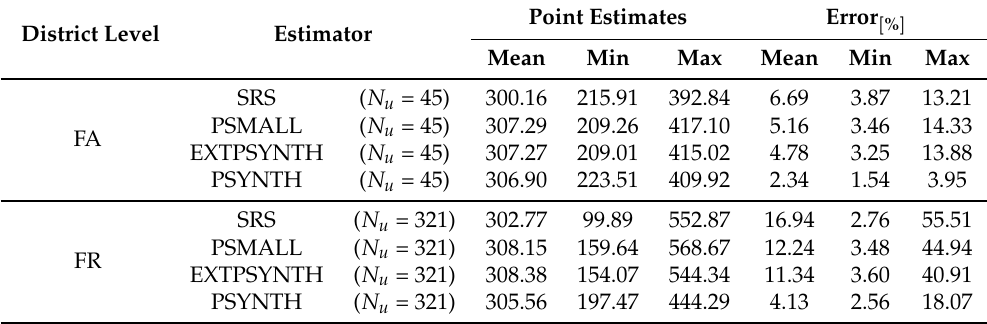
Table 6. Descriptive summary of point estimates and estimation errors for the volume of growing